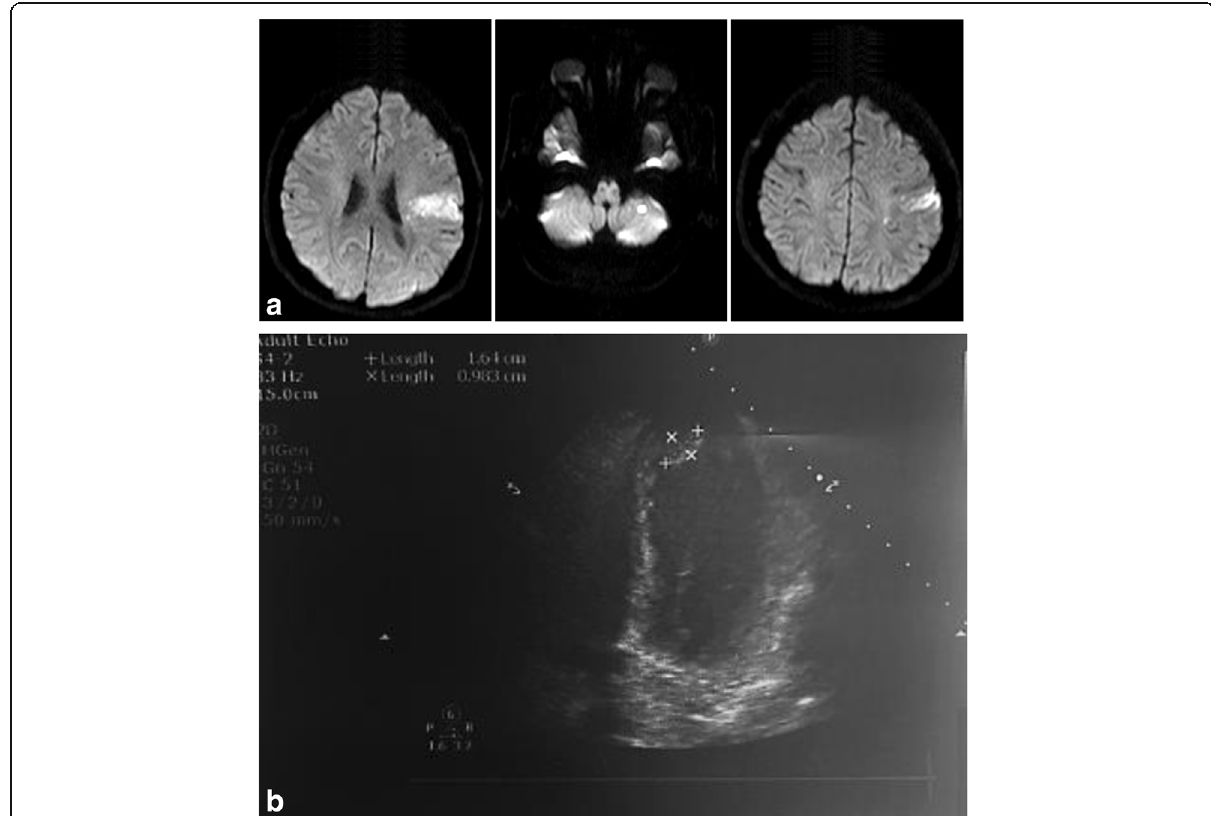
Fig. 2 a MRI DWI of patient 10 with left insular and cerebellar infarction. b ECHO of patient 10 with fresh apical thrombus measuring 12 × 16 mm, EF 35%, akinetic all apical segment, mid-anterior wall, mid-anterior septum, and mid-posterior